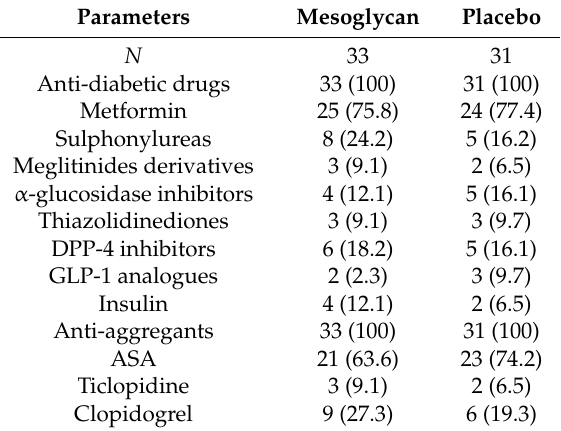
Table 3. Concomitant